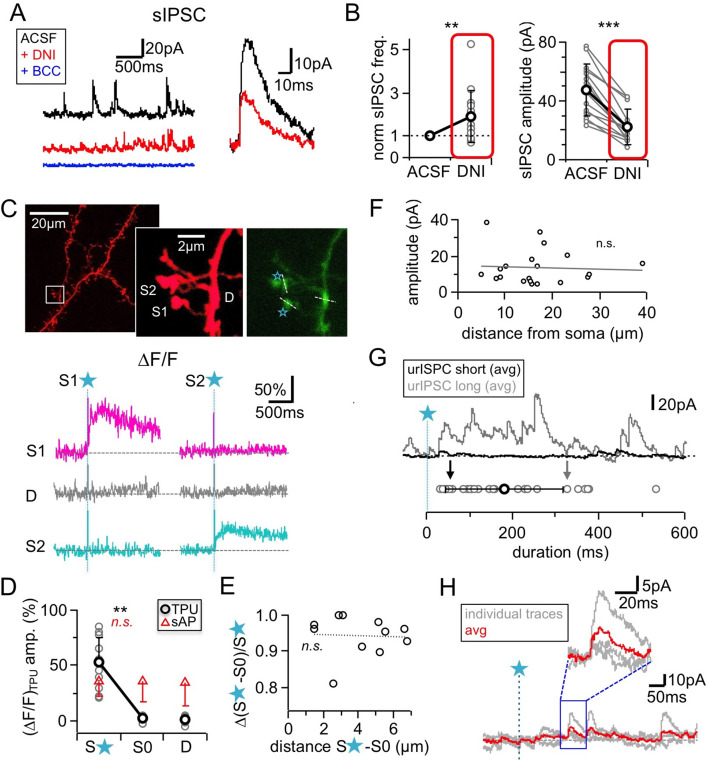
Effects of DNI (1 mM) on sIPSCs, spine-specificity of TPU, TPU sites, duration of responses.(A) Left: Example recordings in ACSF, after DNI wash-in and with added bicuculline (BCC, 50 µM). Right: Representative single events before and after DNI wash-in. (B) Summary of effects of DNI (red) on spontaneous IPSCs. Left: Frequency. Right: Absolute amplitude. (n = 14 MCs each). (C) Effect of uncaging on non-stimulated adjacent GC spines (S1, S2). Representative experiment. Top: Z-projections of two-photon scan of GC dendrite and spine pair filled with Alexa594 and OGB-1 (right panel, see Materials and methods). Locations of TPU marked with blue stars, location of line scans marked with white dashed lines. Bottom: Averaged fluorescence transients recorded in both spine heads and dendritic shaft in between in response to TPU at S1 only (left) and TPU at S2 only (right). (D) Cumulative data from 11 spine pairs. gray circles: Individual ∆F/F amplitudes in stimulated spine, non-stimulated spine S0 and dendritic shaft. Black circles: mean values. Red triangles: Mean ∆F/F amplitudes in response to single somatically evoked action potential. No significant difference across all three compartments. (E) Cumulative data from the same 11 spine pairs. Linear regression between relative difference in ∆F/F in the stimulated vs the non-stimulated spine head (y-axis) and the distance between the spine head centers (x-axis). No correlation was found (Pearson’s correlation coefficient r = −0.17, p=0.31). (F) Distance of TPU site from soma vs urIPSC amplitudes. There was no detectable correlation (n = 20 MCs, Pearson’s correlation coefficient r = −0.07, p=0.39). (G) Top: Exemplary averaged responses from two experiments. Bottom: Cumulative durations of triggered events (black and gray arrow: durations of exemplary averaged responses). (H) Exemplary experiment with a long latency of first detectable response (see Materials and methods). Inset: Magnification of responses.